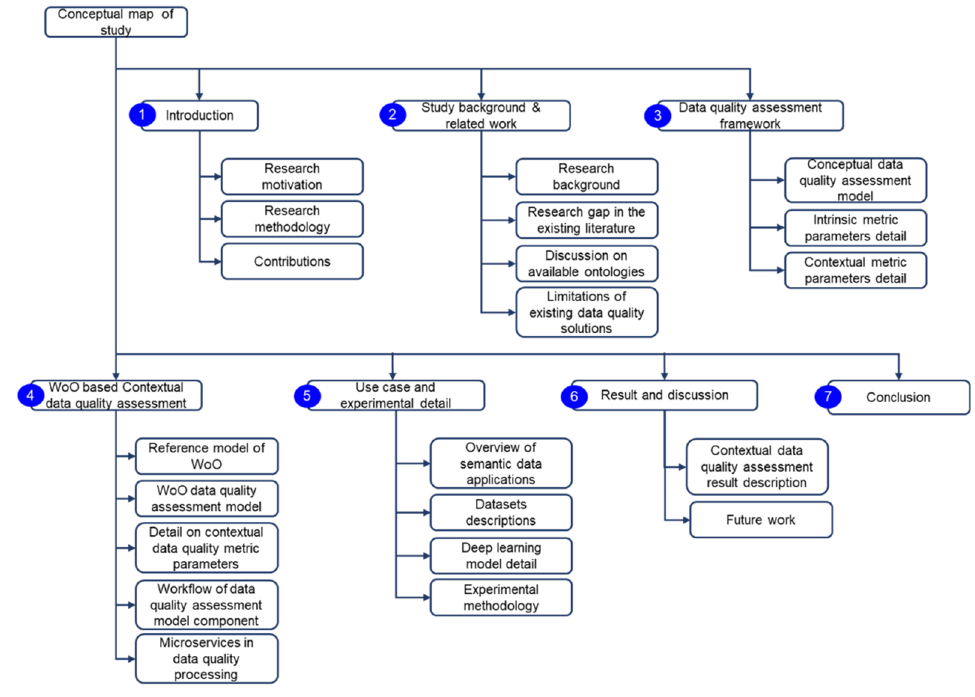
Figure 2. Conceptual map of study .